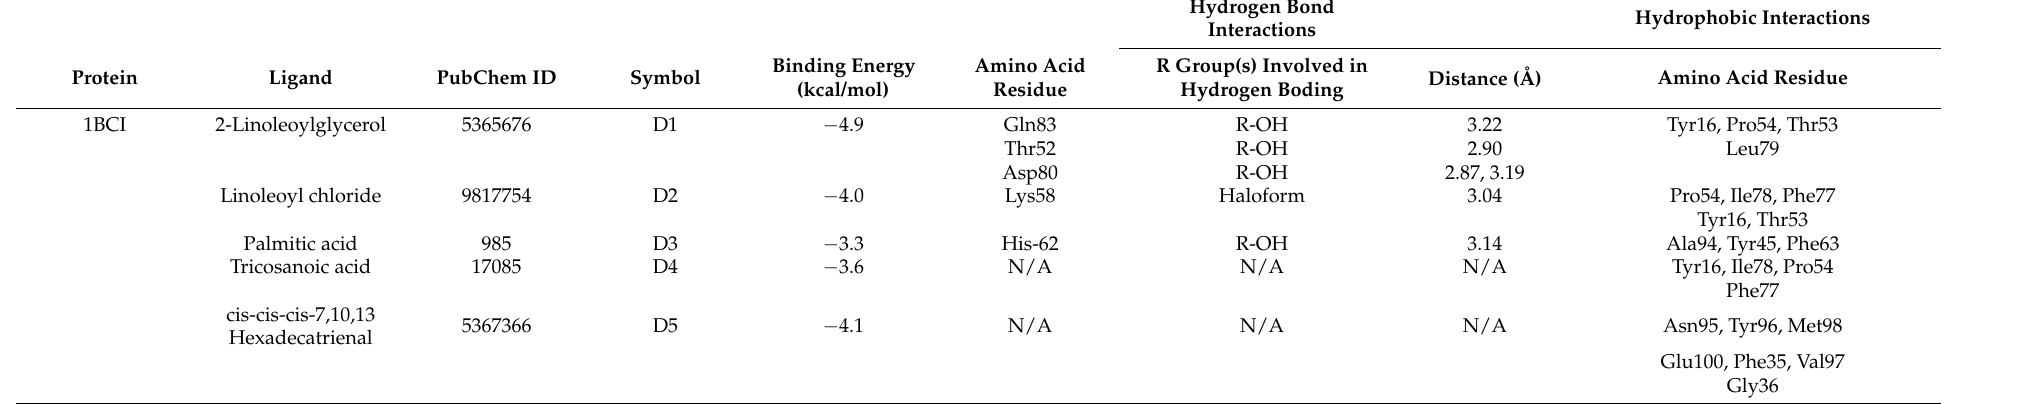
Table 8. Binding energy of potential bioactives on PLA2G4A (PDB ID: